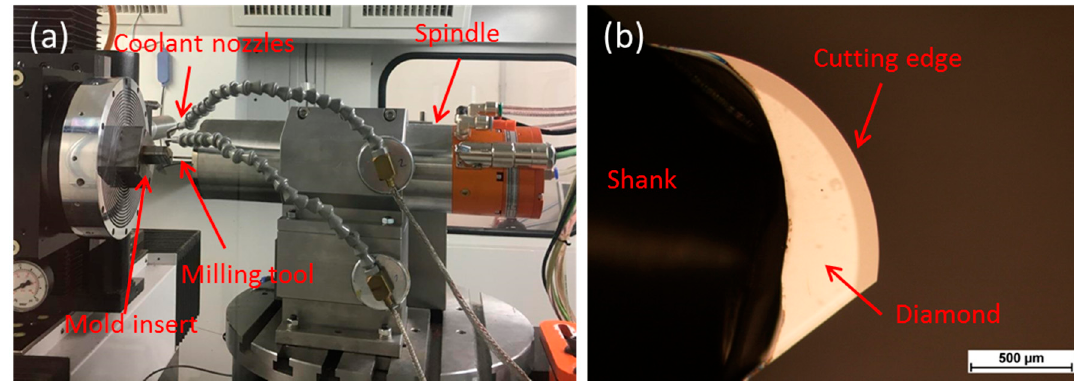
Figure 3. ( a ) UP-milling of the mold insert; ( b ) Cutting edge of the diamond cutting tool.